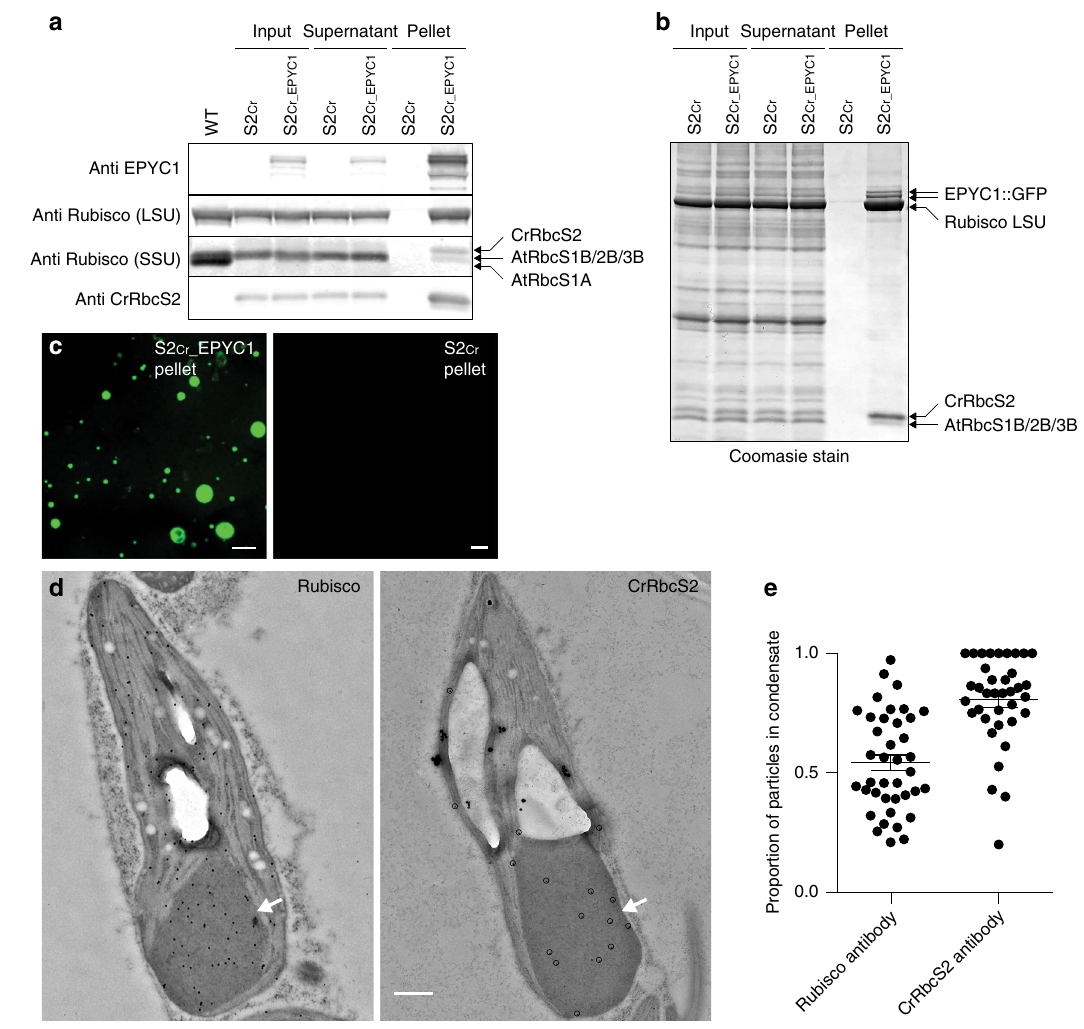
Fig. 3 Condensates contain EPYC1 and plant-algal hybrid Rubisco. a EPYC1 and Rubisco protein levels in whole leaf tissue (input), the supernatant following condensate extraction and centrifugation (supernatant) and the pellet (pellet) as assessed by immunoblot analyses with anti-EPYC1, anti-Rubisco (LSU and SSU shown) or anti-CrRbcS2 antibodies. Samples are shown for WT plants (WT), and S2 Cr mutants not expressing EPYC1 (S2 Cr ) and expressing EPYC1-dGFP (S2 Cr _EPYC1). The pellet is 40× more concentrated than the input and supernatant. Molecular weights: LSU, 55 kDa; RbcS1B, RbcS2B and RbcS3B, 14.8 kDa; AtRbcS1A, 14.7 kDa; CrRbcS2 15.5 kDa. The immunoblots shown were derived from the same experiment and gels/blots were processed in parallel. Immunoblots results were representative of four gels/blots for EPYC1, two for Rubisco, and one for CrRbcS2. b Coomassie-stained SDS-PAGE gel showing the composition of the pelleted condensate. Images are representative of three gels. c The condensates in the S2 Cr _EPYC1 pellet coalescence to form large liquid droplets. Scale bars = 25 µ m. d Representative immunogold labelling of Rubisco in chloroplasts of an S2 Cr transgenic line Ep3 expressing EPYC1-dGFP probed with polyclonal anti-Rubisco (left) or anti-CrRbcS2 (right) antibodies (dots are highlighted for the latter). The condensates are marked by a white arrowhead. Large white structures are starch granules. Scale bar = 0.5 µ m for both images. e Proportion of gold nanoparticles inside the condensate compared to the chloroplast for each antibody. The mean ± SEM are shown for n = 37 individual chloroplast images. Source data are provided as a Source Data fi